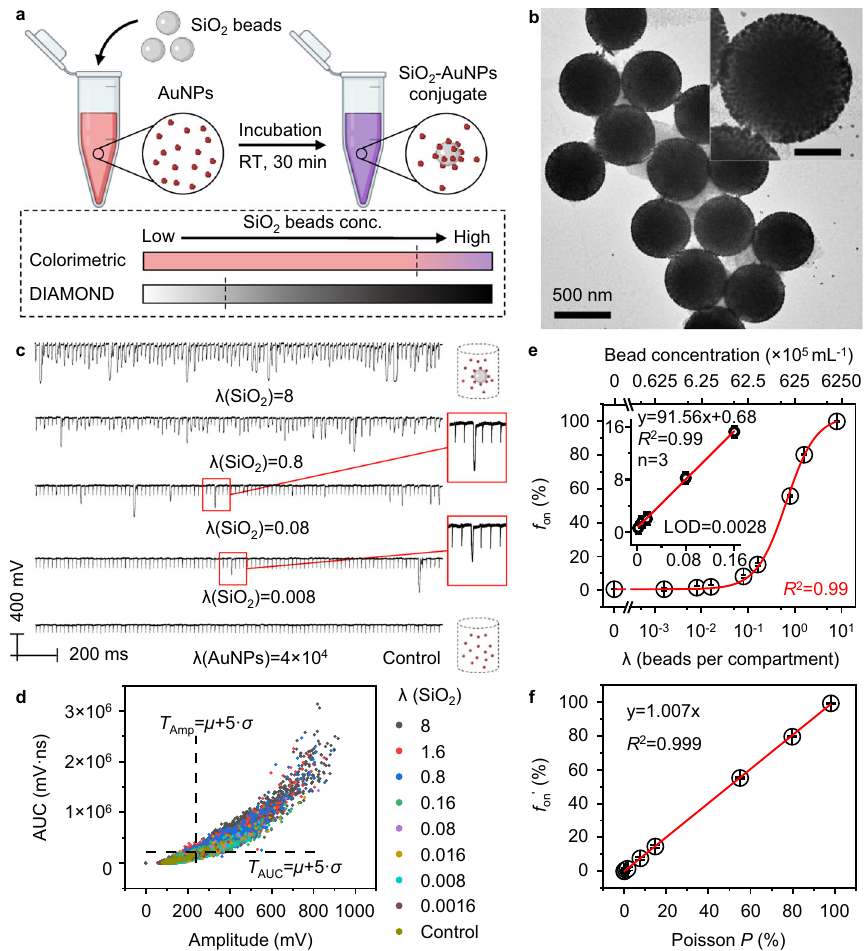
Fig. 4 Detection of SiO 2 beads in a homogeneous assay by DIAMOND. a Schematic of a homogeneous assay of SiO 2 beads by AuNPs as a pair of targets and probes at room temperature (RT). Lower panel shows that when bead concentrations are insuf fi cient to induce the color change, DIAMOND